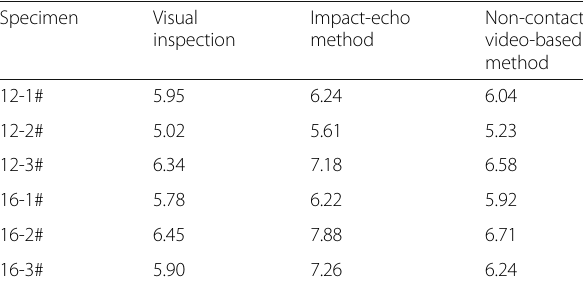
Table 3 Comparison of depth measurements among different methods (unit: cm)